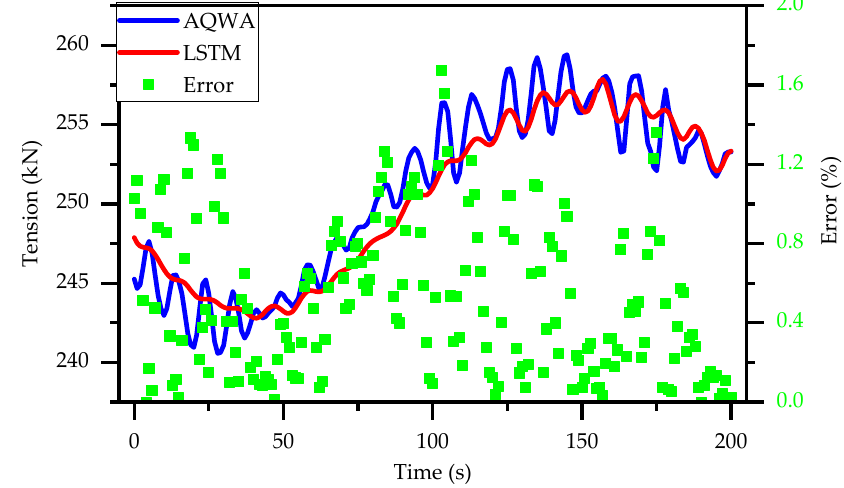
Figure 11. Error analysis of AD35 Mooring Line 4.